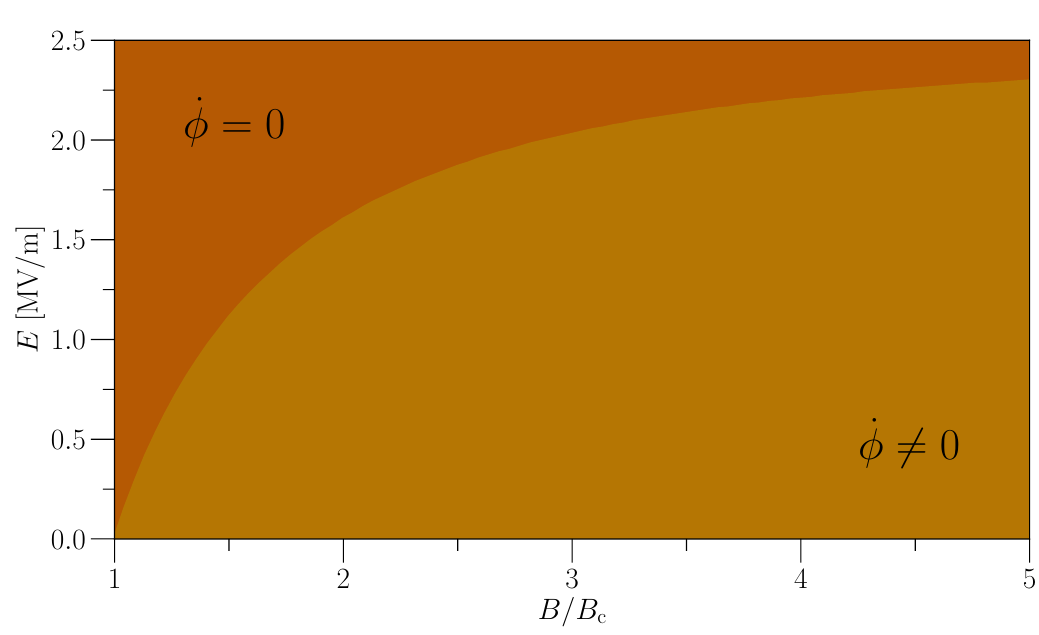
/ B , and magnetic, B , field dependence of the boundary z z c